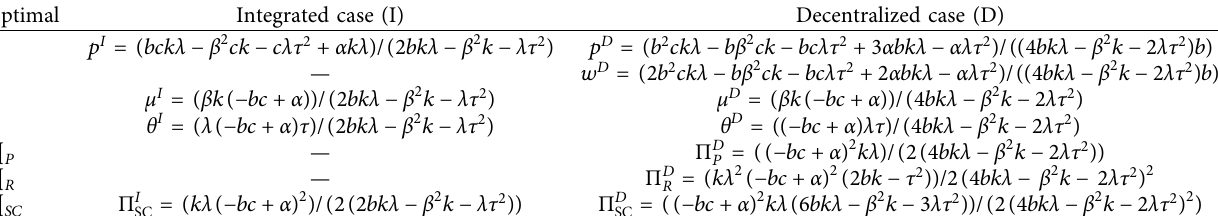
Table 2: Equilibrium solutions under the integrated and decentralized